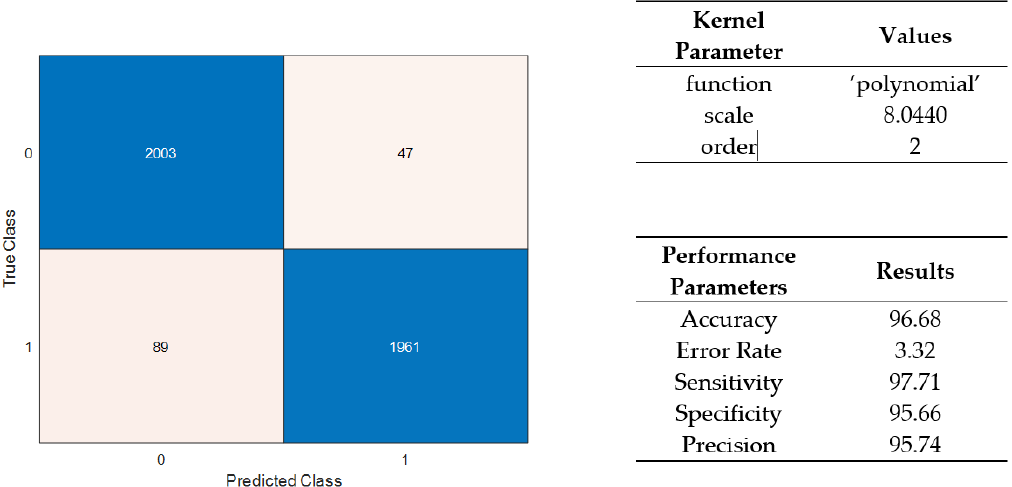
Figure 12. Confusion matrix and performance results for a quadratic SVM.